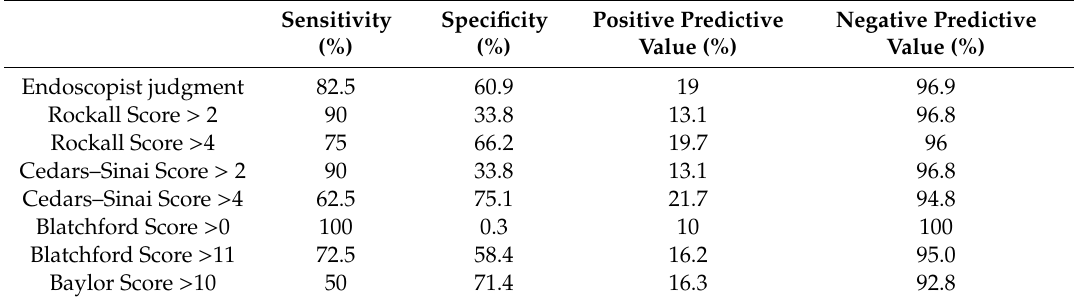
Table 3. Sensitivity, specificity and positive predictive values for rebleeding (all patients).